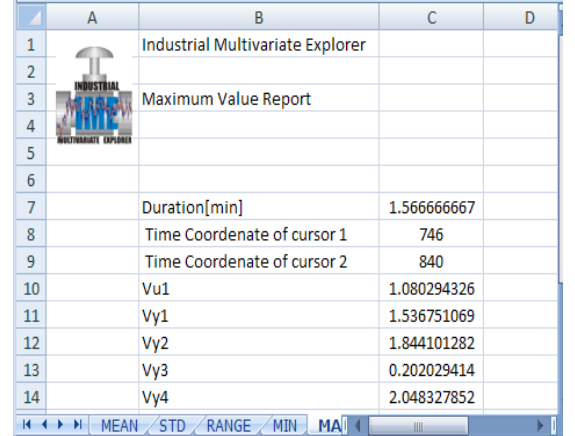
Figura 10. Plantilla para salva de cálculo de estadígrafos. Formato de fecha y